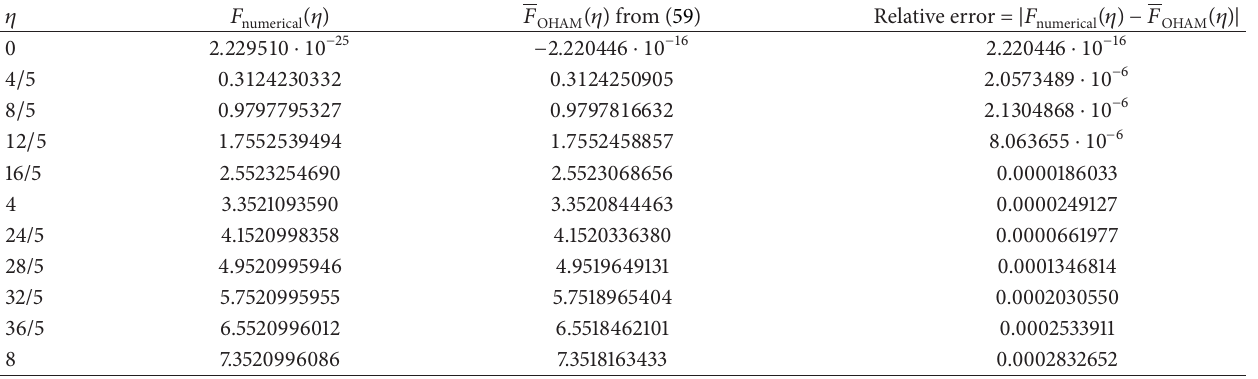
Table 12: Comparison between OHAM results given by (59) and numerical solutions for 𝛽 = 1 . 𝜂 𝐹 (𝜂) numerical